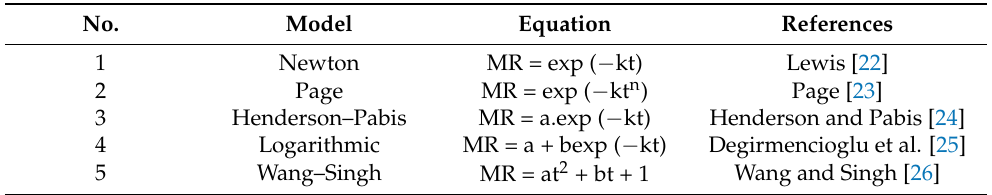
Table 1. Mathematical models and equations employed for RCM drying. No.